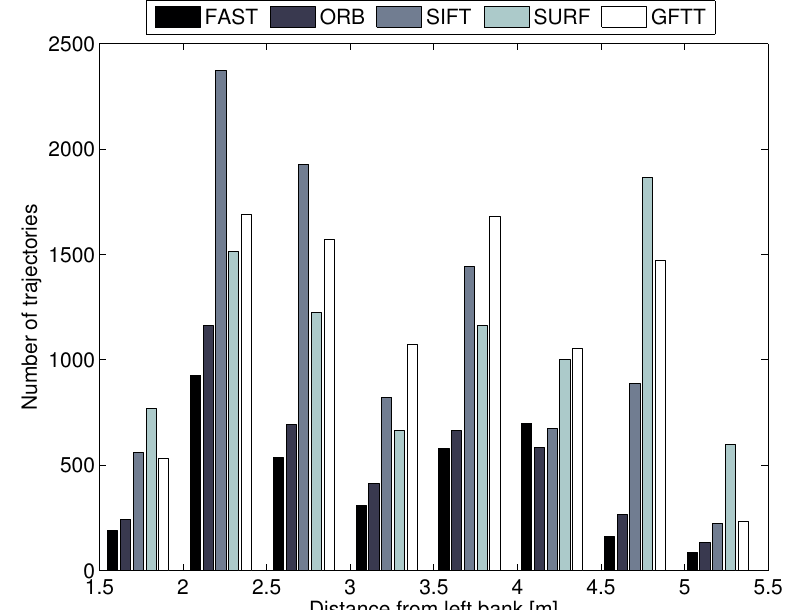
Figure 3. Number of trajectories per vertical region as obtained for a representative image sequence on the Brenta River with the five different feature